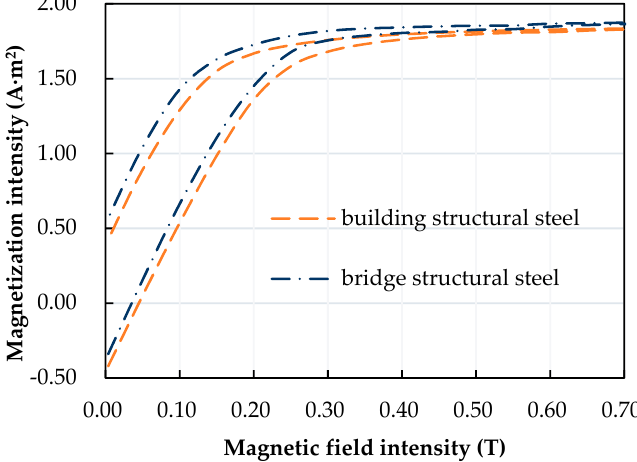
Figure 1. Magnetization curves of Q420B structural building steel and Q420qD bridge steel. Di ff erent brands of materials have di ff erent production processes. For the di ff erent grain structures